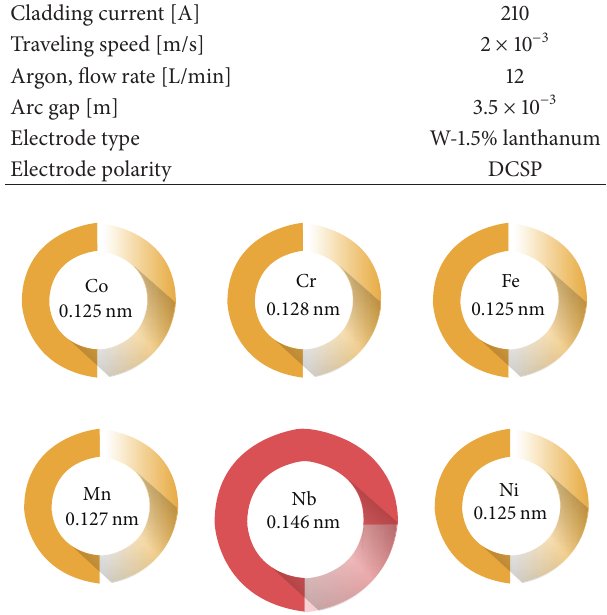
Figure 1: Atomic radii of elements.